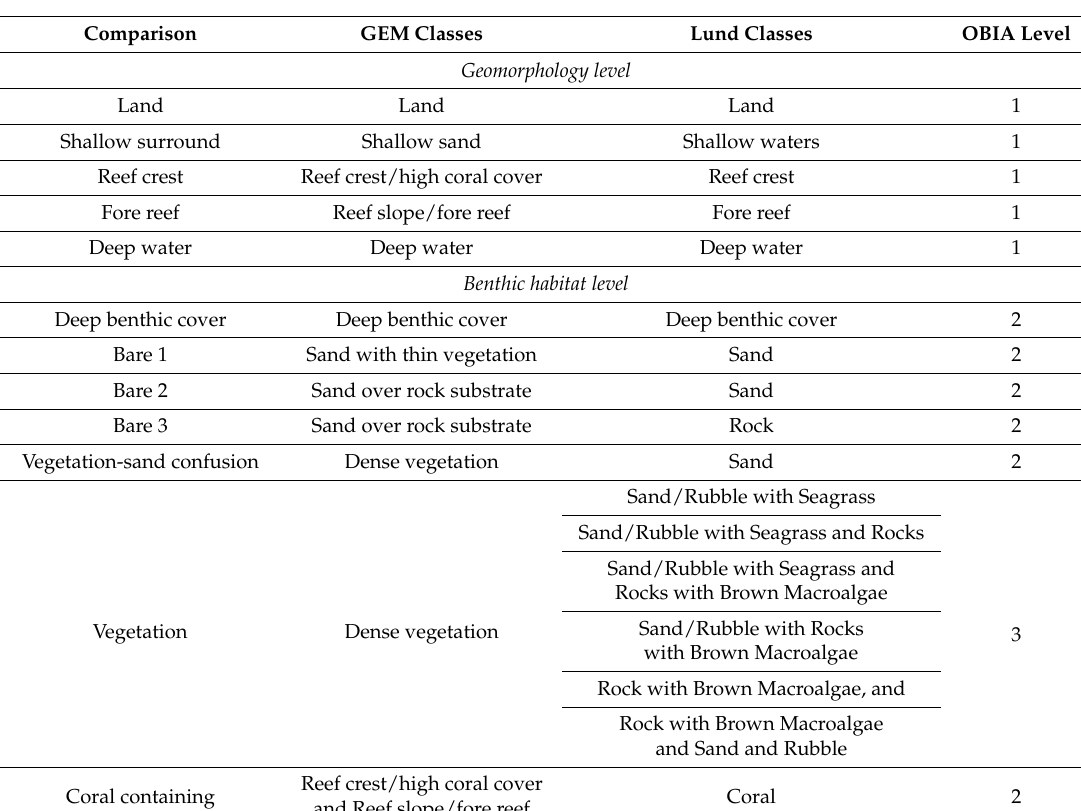
Table 5. Pairing of selected classes for